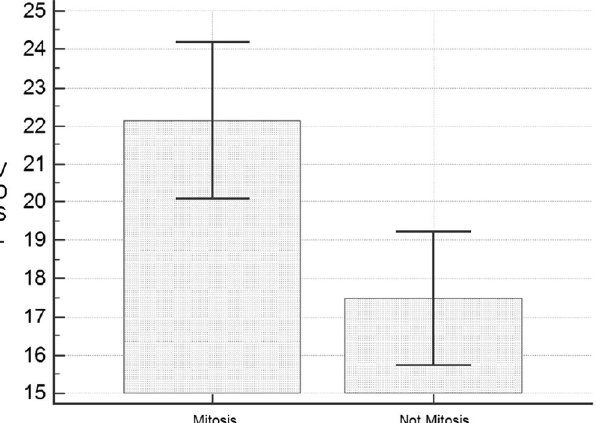
Figure 4. Comparison of VDSL (vitamin D serum levels) between patient with mitotic (80 subjects) and non mitotic melanoma (65 subjects). p =